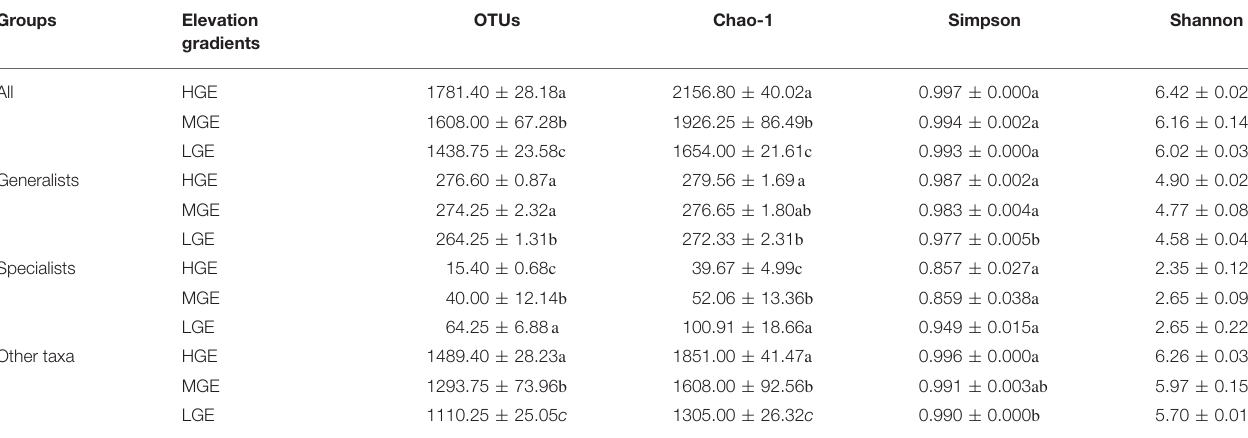
TABLE 2 | Phylotype richness and diversity estimators of the microbial communities among three elevational gradients. Groups